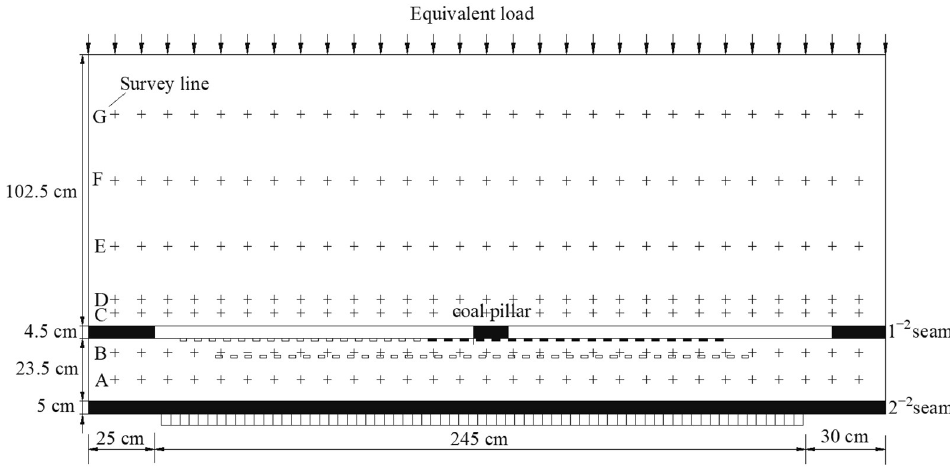
Figure 3. Schematic diagram of physical simulation experiment. Table 1. Material ratio of physical simulation experiment.